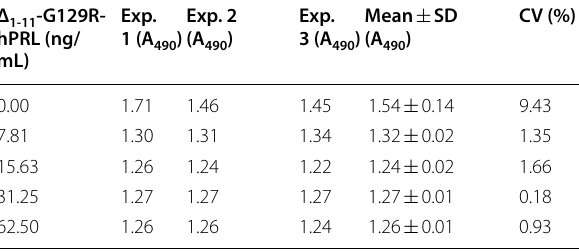
SD: standard deviation; CV: coefficient of